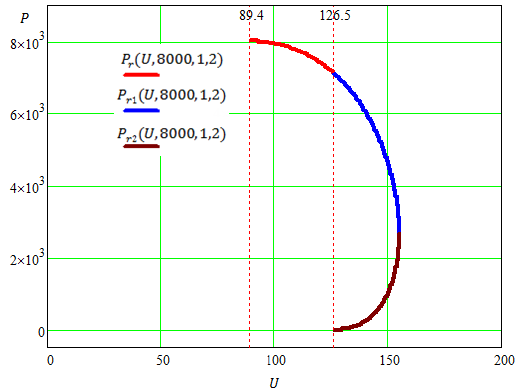
Figure 10. The set of the correct solutions of Equation (8).